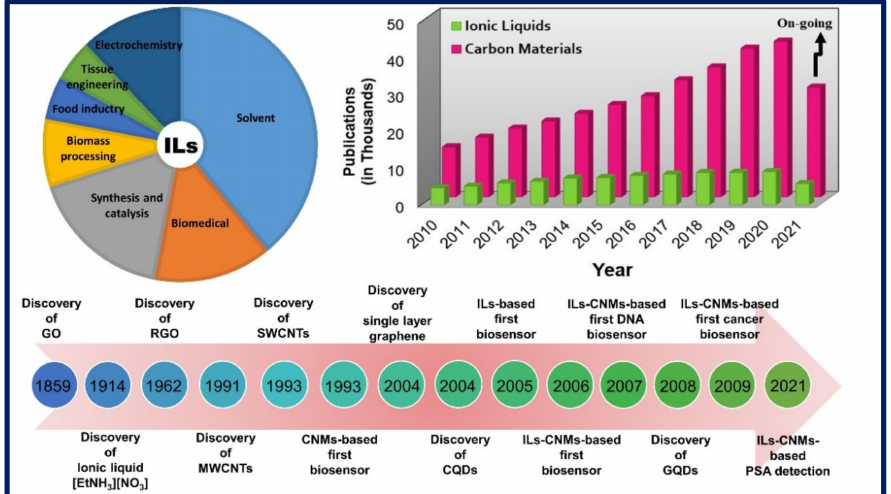
Figure 1. Pie chart of applications of ILs and historical discovery and applications perspective of ILs and carbon materials. Reprinted with permission from Ref. [3]. Copyright 2019, Royal Society of Chemistry; bar graph displays the number of publications per year from 2010 to 2021. (Source: Web of Science, Keyword: Ionic Liquids, and Carbon Materials, Last accessed date: 21 September